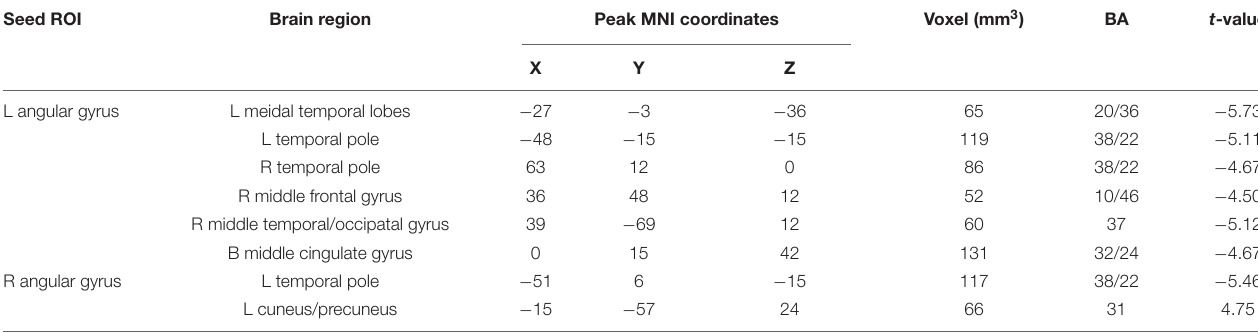
TABLE 2 | Abnormal functional connectivity in the patients with type 2 diabetes mellitus compared to the healthy controls. Seed ROI Brain region Peak MNI coordinates